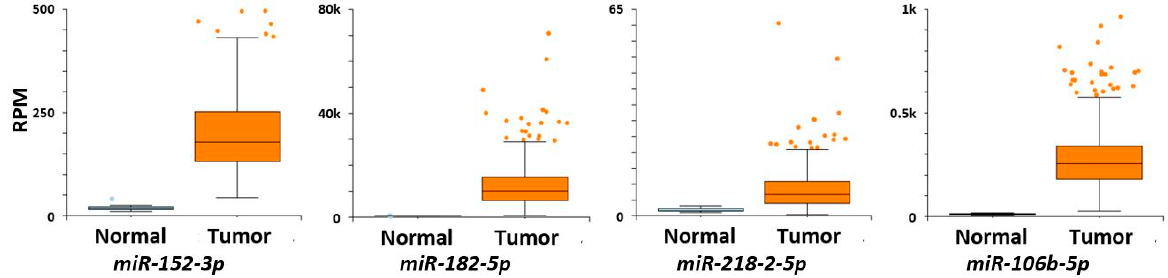
Figure 2. Box chart graphs of miRNA levels in normal colon (left box) compared to CRC (right box) (Y axis = normalized RNA-seq data (RPM)).